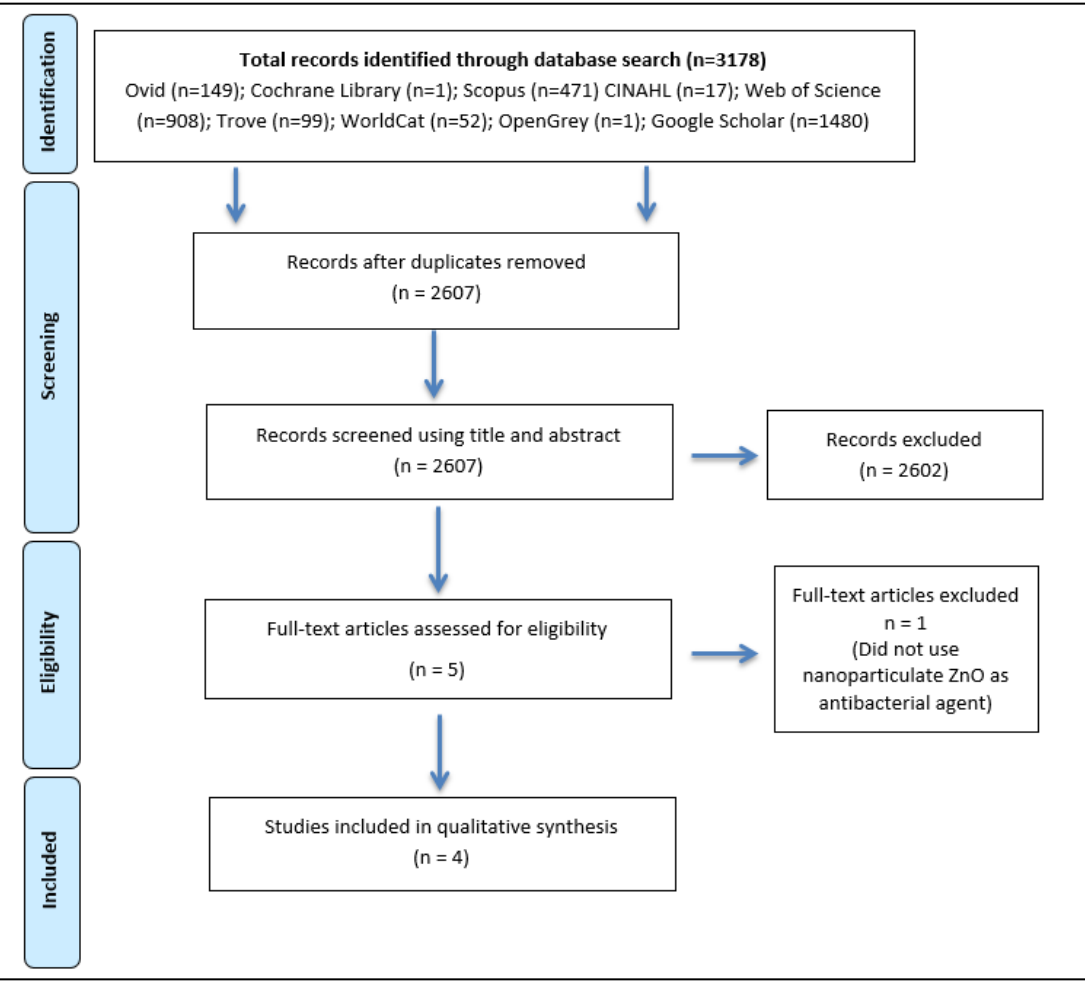
Figure 1. Preferred Reporting Items for Systematic Reviews and Meta-Analyses (PRISMA) flow diagram.